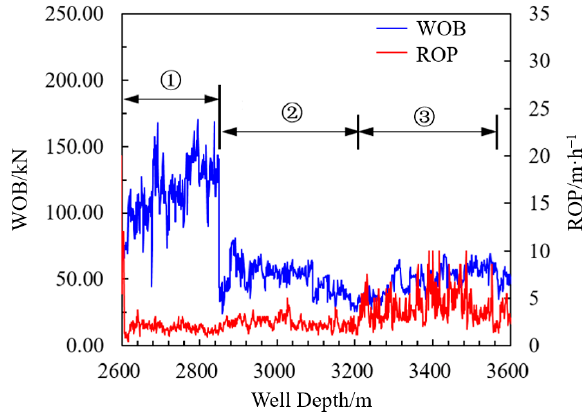
Figure 19. Comparison of WOB and ROP in the applied well interval. Table 6. Comparison of field test results of different drilling